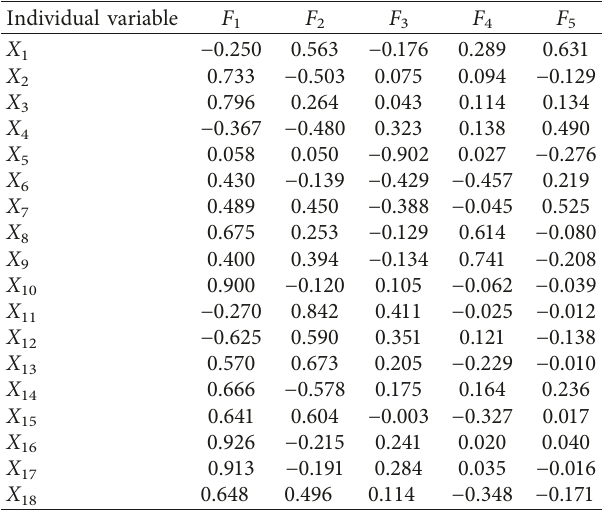
Figure 1: Cooking characteristics of sorghum: (a) water absorption rate; (b) volume expansion ratio; (c) iodine blue Table 3: The loadings of the individual variables as calculated during PCA.